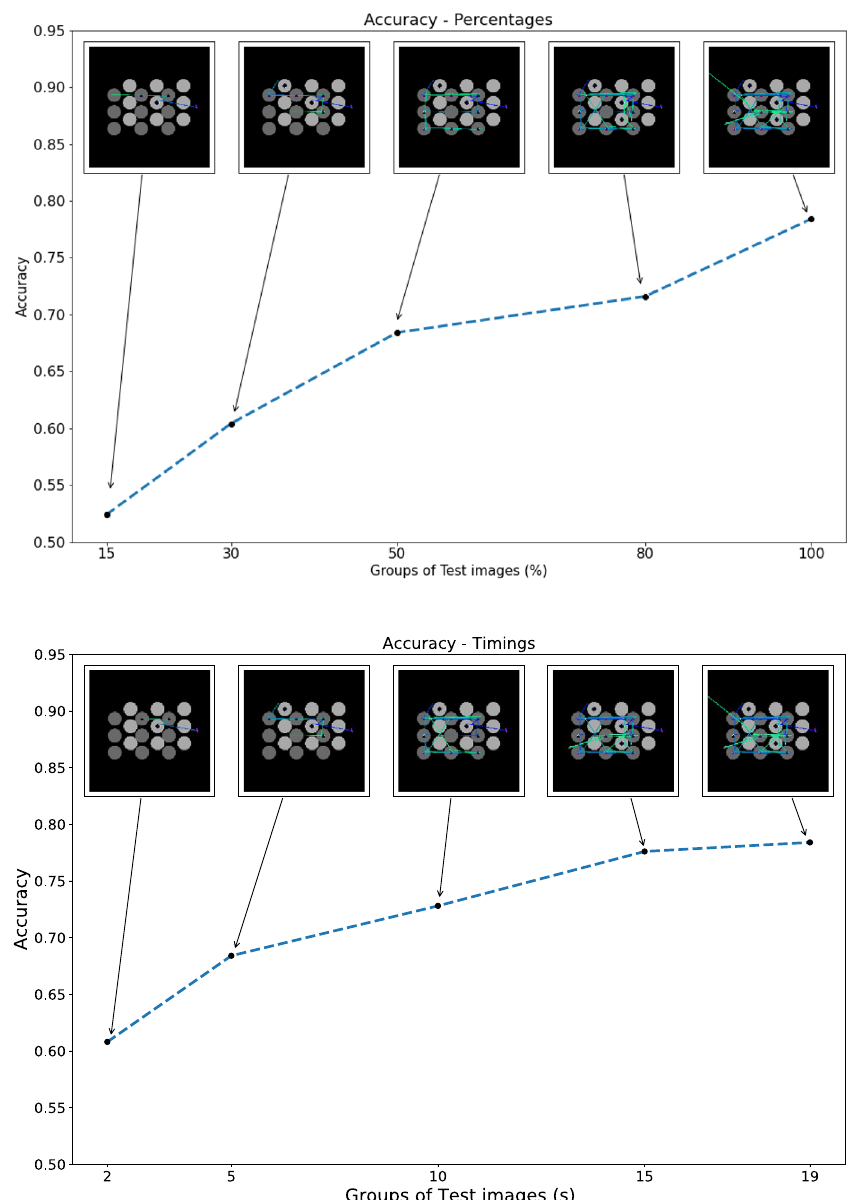
Figure 4. Accuracy of VGG-19 model in CT 1 using subsequences via percentages ( i ) and time points ( ii